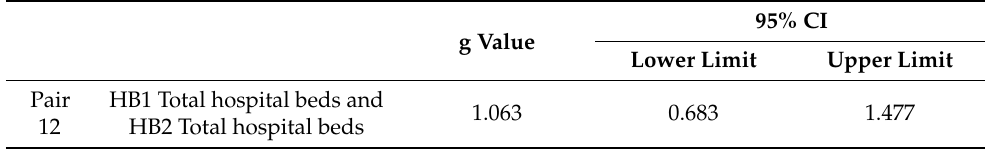
Table 10. Effect sizes for Hedge’s g dependent